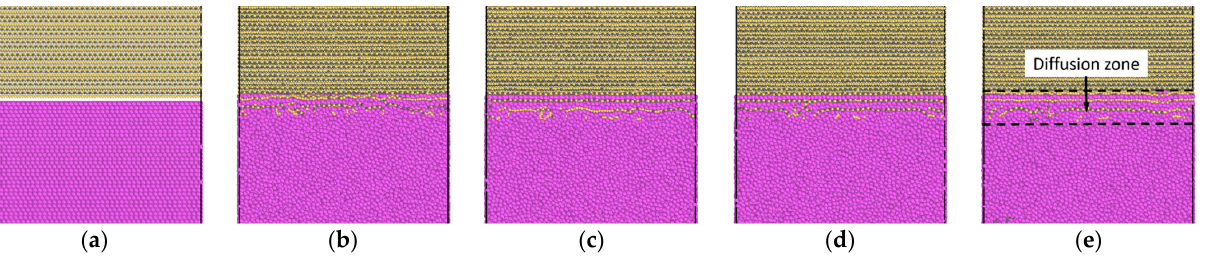
Figure 3. Cross-sectional views of the atomic configurations of C-terminated 3C–SiC/Al interface. ( a ) Atomic structure at 300 K before relaxation and the configuration after maintaining the system at 2000 K for ( b ) 0 ns, ( c ) 2 ns, ( d ) 4 ns, and ( e ) 6 ns.